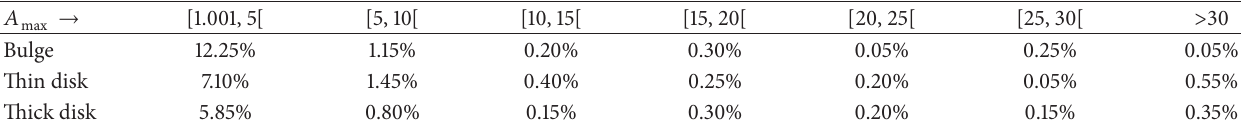
Table 1: For different populations of FFPs in the Galactic bulge and thin and thick disks and assuming the mass function index 𝛼 give the percentage of expected events in each indicated bin for the magnification peak value.